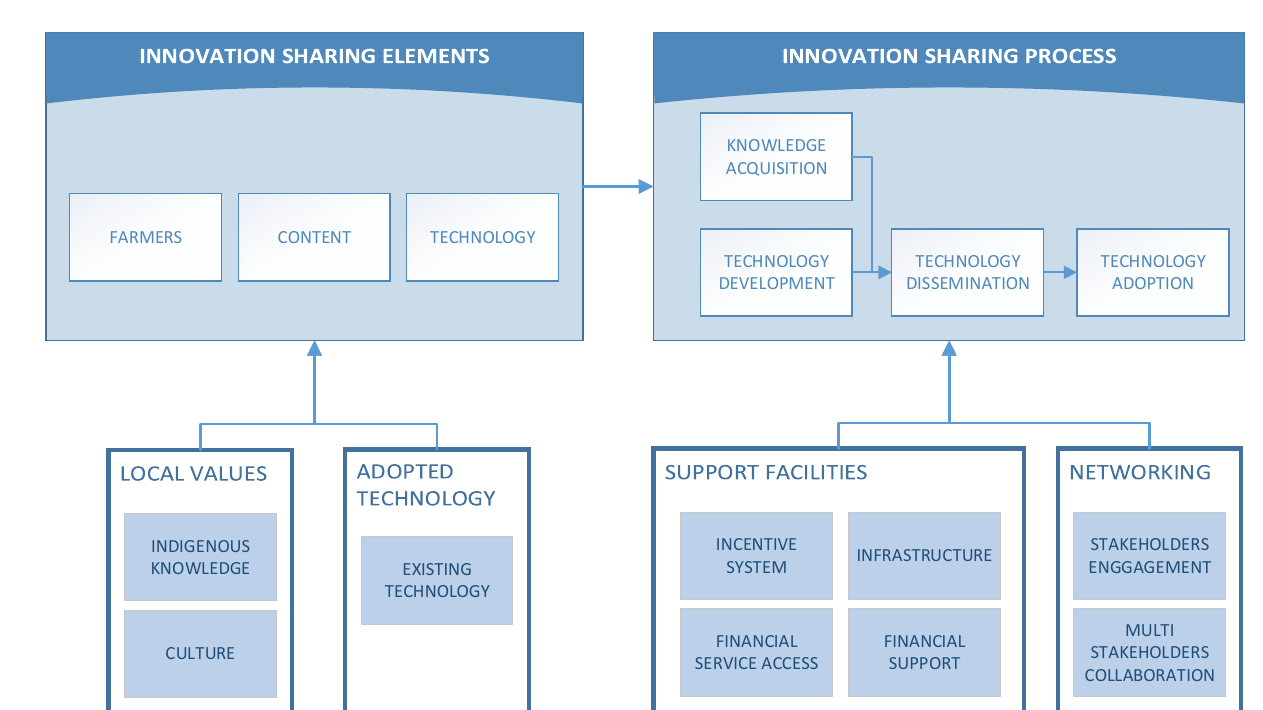
Figure 6. Proposed model of innovation sharing for smallholders.